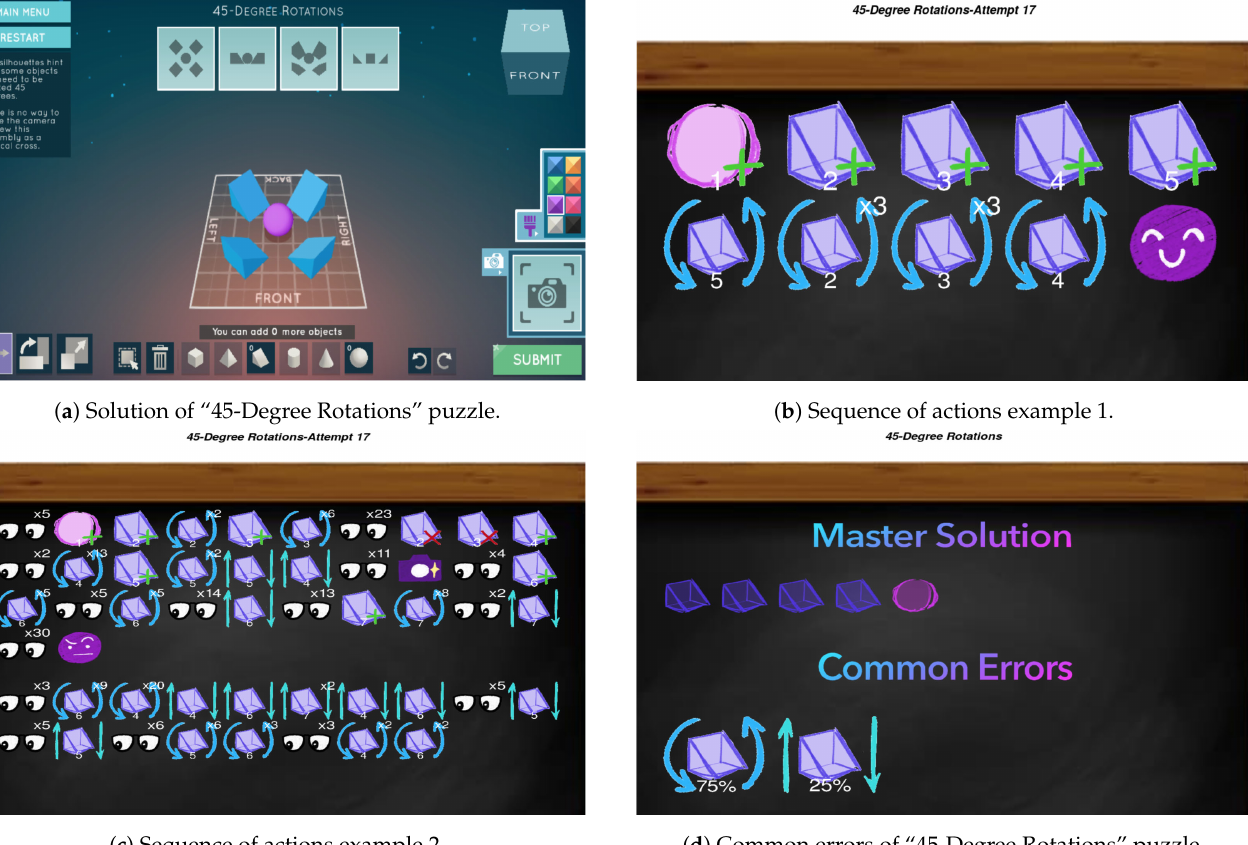
Figure 6. “45-Degree Rotations” puzzle and visualization examples in Shadowspect